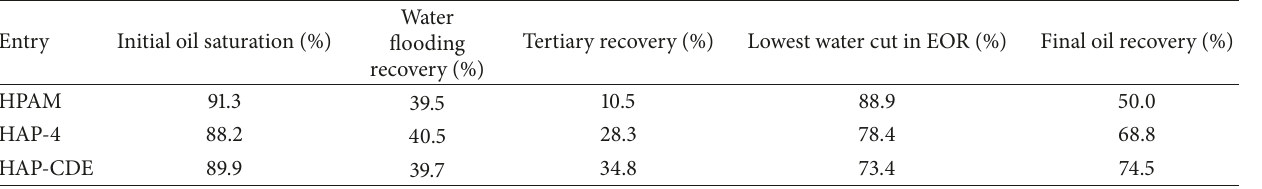
Table 3: Oil recovery from sand pack